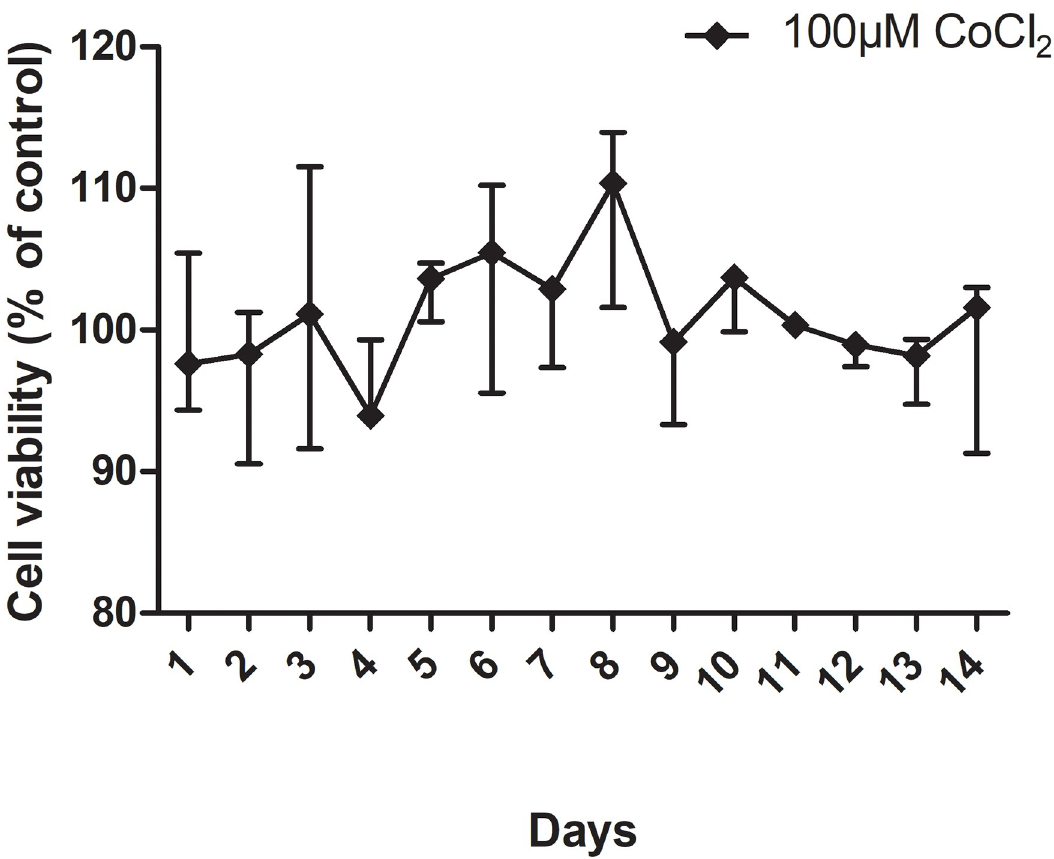
Fig 2. Cell viability of HaCaT cells cultured in 0.15 mM calcium and exposed to 100 μ M CoCl 2 for 14 days. The cell viability is expressed as fluorescence signal of exposed cells compared to unexposed control cells (the latter regarded as 100% viability). The values represent mean and range (minimum and maximum values). The long-term effect of low cobalt exposure on cell viability for 14 days was non-significantly different from control